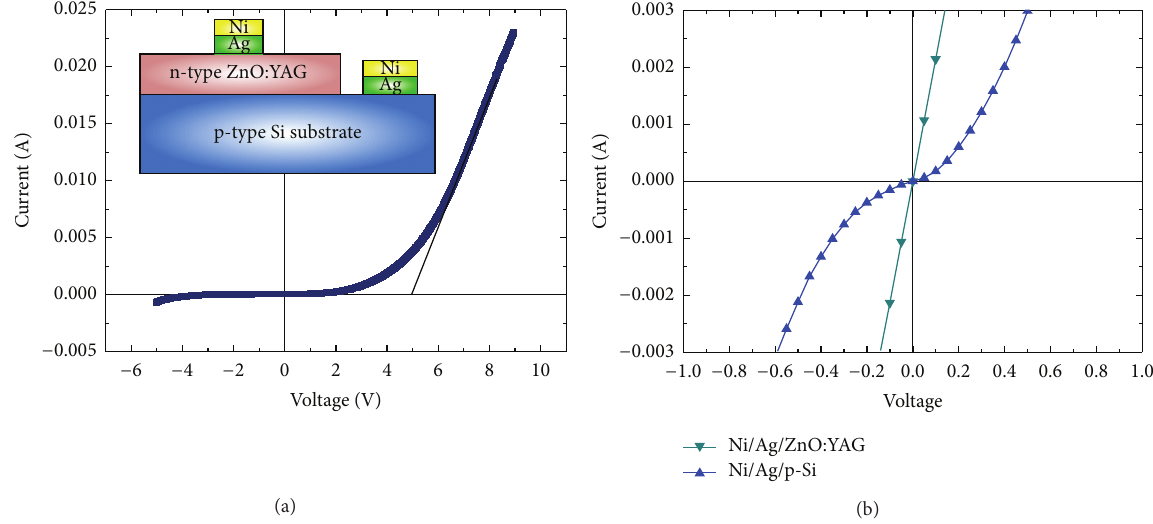
Figure 8: (a) Typical current-voltage characteristics of ZnO:YAG/silicon nanostructure diode. The inset shows the cross-section of the completed structure of the ZnO:YAG/silicon nanostructure diode. (b) The current-voltage ( 𝐼 - 𝑉 ) characteristics of Ni/Ag/ZnO:YAG and Ni/Ag/p-Si junctions,